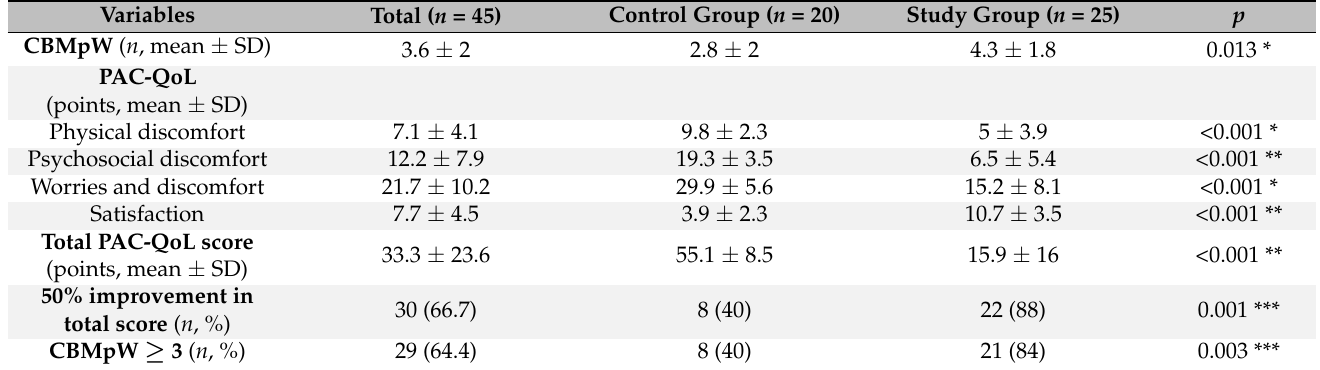
Table 3. Comparison between groups in terms of post-treatment stool frequency and quality of life